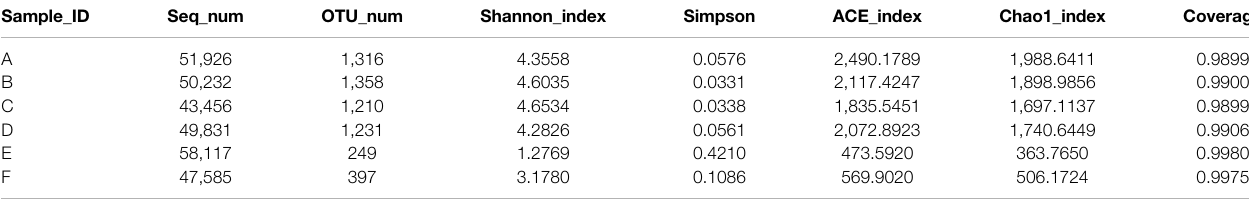
TABLE 1 | Comparison of the abundance and diversity of intestinal micro fl ora of the rats before and after